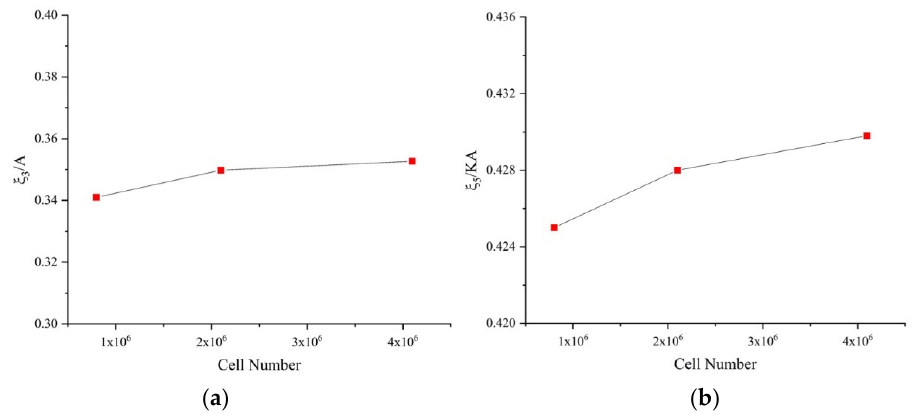
Figure 9. Mesh convergence test. ( a ) Heave; ( b ) Pitch.